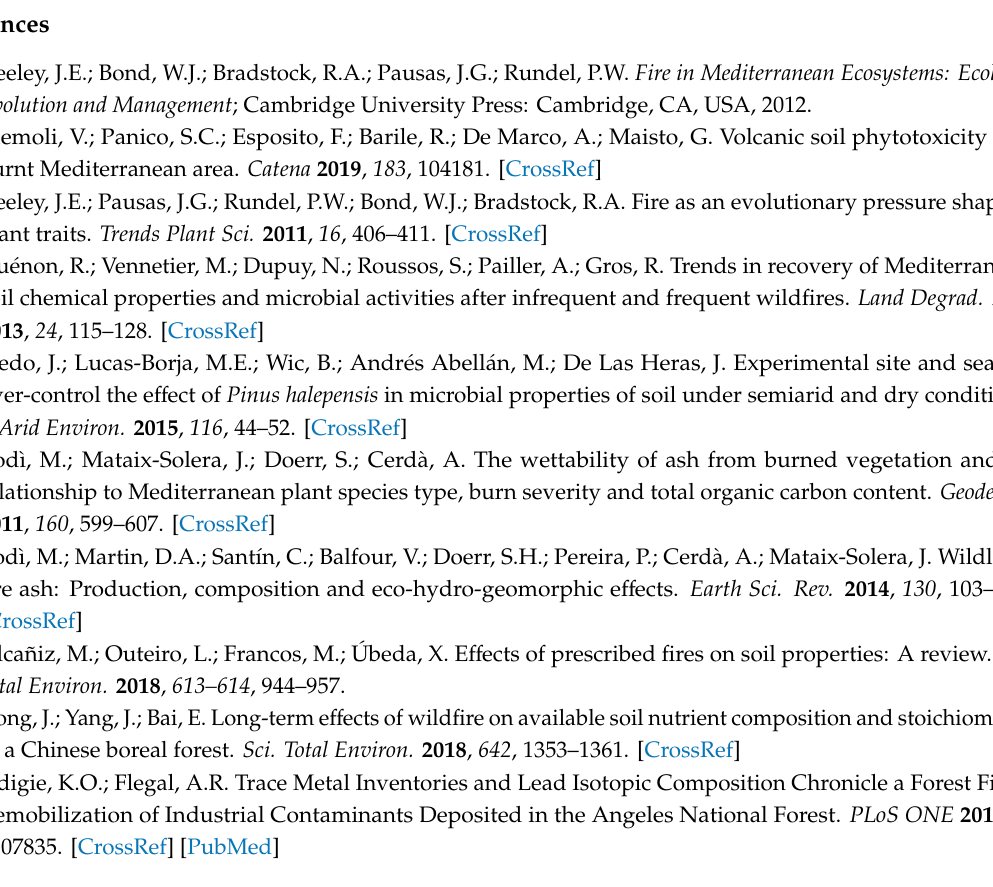
Figure A1. Mean temperatures (black points) and sum of rainfall (white points) measured each month from September 2016 to September 2018 in the sampling area, Vesuvius National Park.